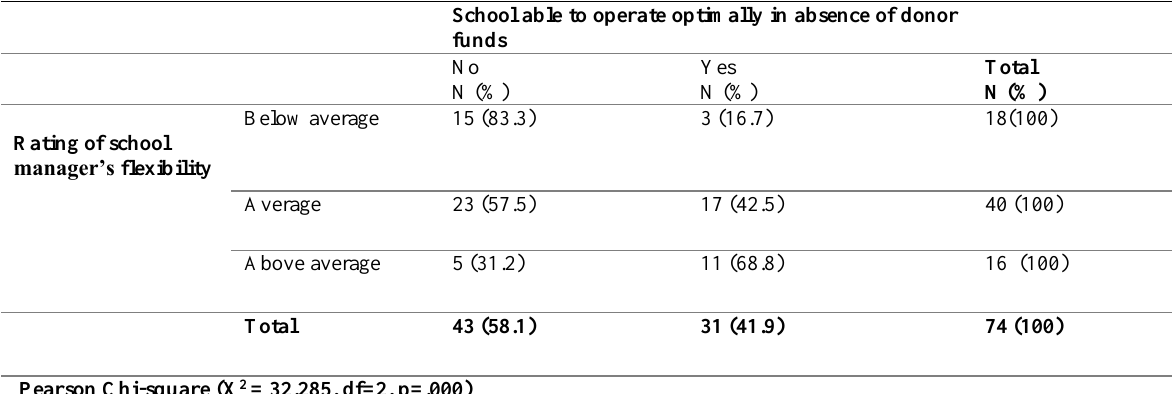
Table 8: Cross-Tabulation of Flexibility and Sustainability beyond Donor Funding School able to operate optimally in absence of